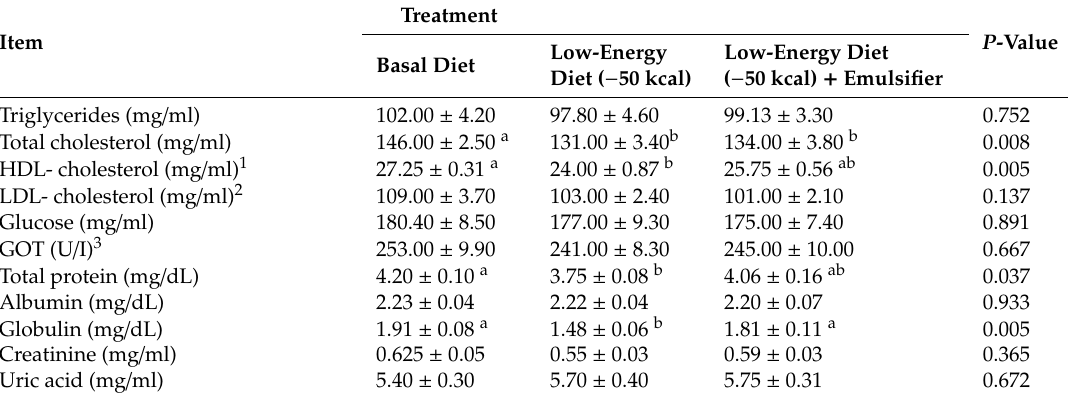
Table 3. E ff ect of test diets on blood plasma parameters.